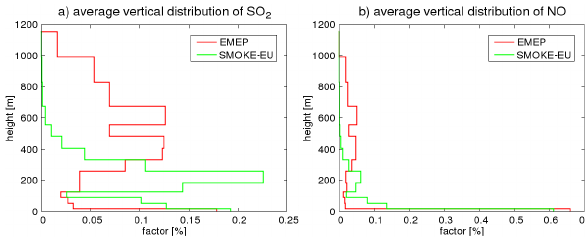
Fig. 11. Average vertical distribution of different emission datasets for the year 2000. (a) SO 2 emissions (b) NO emissions. For comparison with the SMOKE-EU dataset, the official EMEP vertical profiles were interpolated from 6 to 30layers. The TNO- GEMS dataset uses the EMEP vertical distributions. All values are averages over a 54 × 54km 2 domain (Fig.